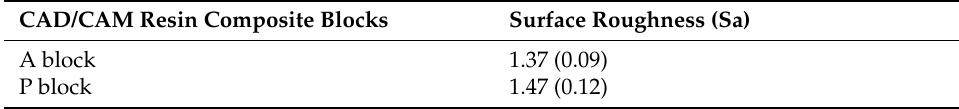
Table 5. Results of surface roughness measurements.